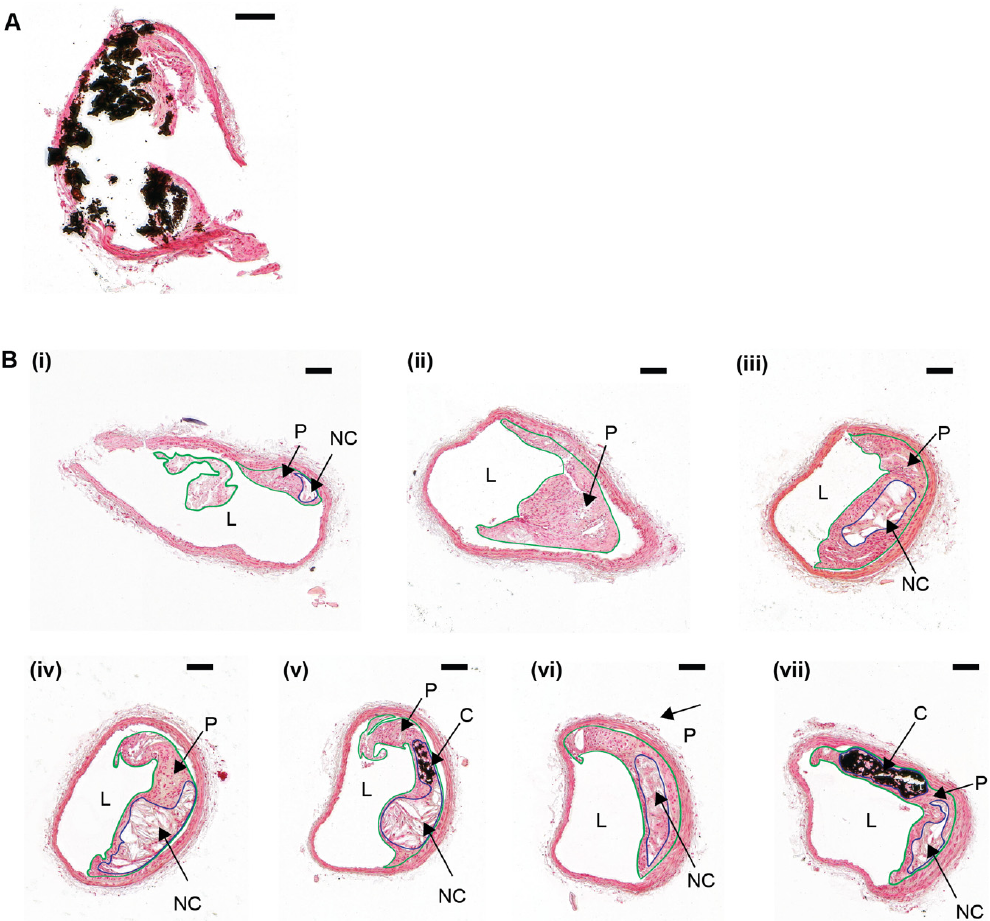
Figure 2. Atherosclerotic plaque calcification heterogeneity in a serially-sectioned brachiocephalic artery from an ApoE − / − mouse. ( A ) Formalin-fixed brachiocephalic artery tissue section from a 10-week old ApoE − / − mouse fed a high fat, high cholesterol diet for 28 weeks. The tissue was taken through a series of graded alcohols and rehydrated, stained with von Kossa, and then counterstained with nuclear fast red. A large calcification (stained black) has “dropped out” during sectioning, resulting in shearing artefacts and tissue damage. ( B ) A formalin-fixed brachiocephalic artery from a 10-week old ApoE − / − mouse fed a high fat, high cholesterol diet for 28 weeks was serially sectioned, collecting a total of 120 sections, with each section—10 µ m in size. Tissue sections were collected from the brachiocephalic artery bifurcation ( B ) / ( i ) into the main brachiocephalic artery trunk ( B ) / ( ii – vii ), and sections every 200 µ m intervals were stained with von Kossa and counterstained with nuclear fast red. The atherosclerotic plaque is outlined in green. The necrotic core, which is an internal lipid-rich region lacking in collagen or cell nuclei but contains cell debris, is outlined in blue. Both atherosclerotic plaque and calcification heterogeneity are noted throughout the brachiocephalic artery. Lumen (‘L’); Plaque (‘P’); Necrotic core (‘NC’); Calcification (‘C’). Scale bar = 100 µ